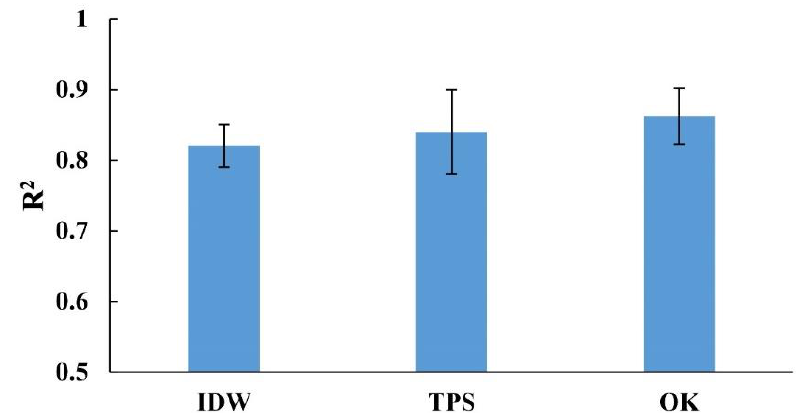
Figure A5. Evaluation of the interpolation method during the years 2003–2015. OK is the ordinary kriging method. TPS is the thin-plate spline function. IDW is the inverse distance weight method.